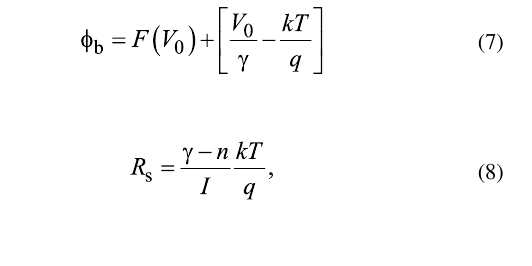
The interfacial layer can passivate the dangling bonds and de- crease the density of interface states. Thus, the ideality factor values approaches unity [25,26]. The decrease of ϕ b values with increasing light power density can be attributed to charge carriers with high energy passing easily the barrier between metal and semiconductor. Also, more charge carriers are gener- ated with increasing light power, and thus diffusion of the charges from the barrier occurs [27].